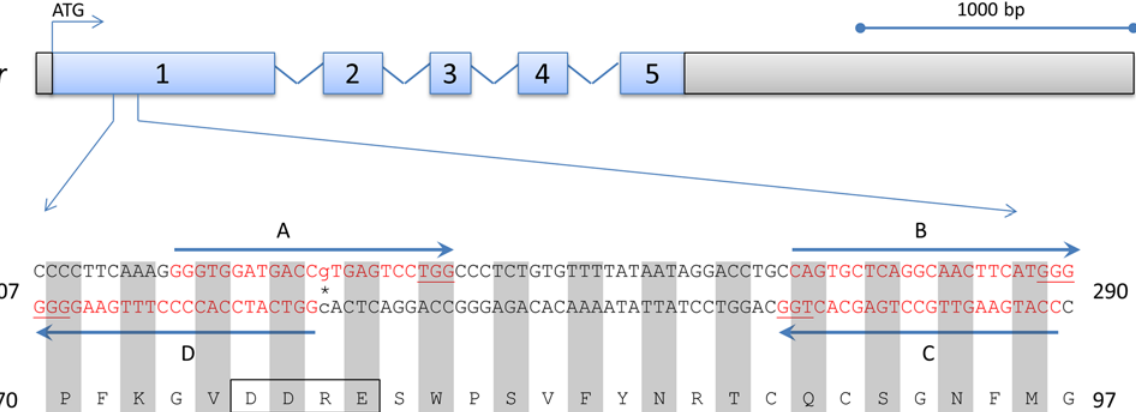
Figure 1. Tyrosinase gene and sgRNA placement. A representation of the WT B6 Tyr (NM_011661.4) coding sequence with the five exons (numbered) and flanking untranslated regions in gray. The region of interest for genome editing is enlarged. The SNM resulting in an eye and coat color change is indicated ( * ) and corresponds to nt 230 with reference to the translation start site. The amino acids encoded are shown below the DNA sequence and the critical “ DDRE ” motif for Tyr function is boxed. Four sgRNAs were designed flanking or including this site with indicated orientations (guides A, B, C, and D). The sgRNA binding sites on the homologous DNA are indicated in red, with the PAM sites underlined.